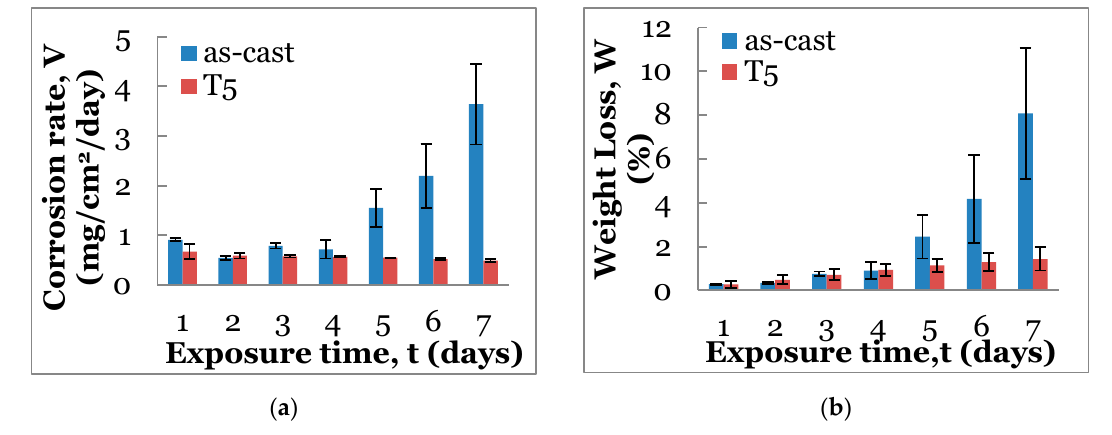
Figure 2. Comparison of ( a ) corrosion rates and ( b ) weight loss.